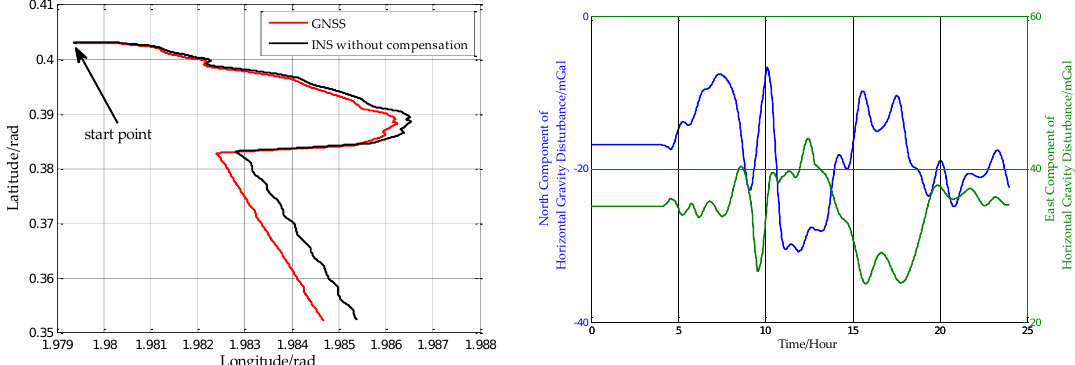
Figure 14. The ( left ) is the ship’s trajectory and the ( right ) is the horizontal gravity disturbance on the ship’s trajectory.